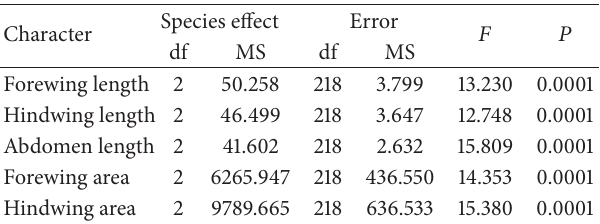
Table 1: Summary of ANOVA describing the variation in five anatomical characters between male Celithemis ornata , C. elisa , and C. fasciata collected from May to July 2015 at Ashmore Heritage Trust Preserve, Greenville County, USA: length of forewing, length of hindwing, abdomen length, area of forewing, and area of hindwing.